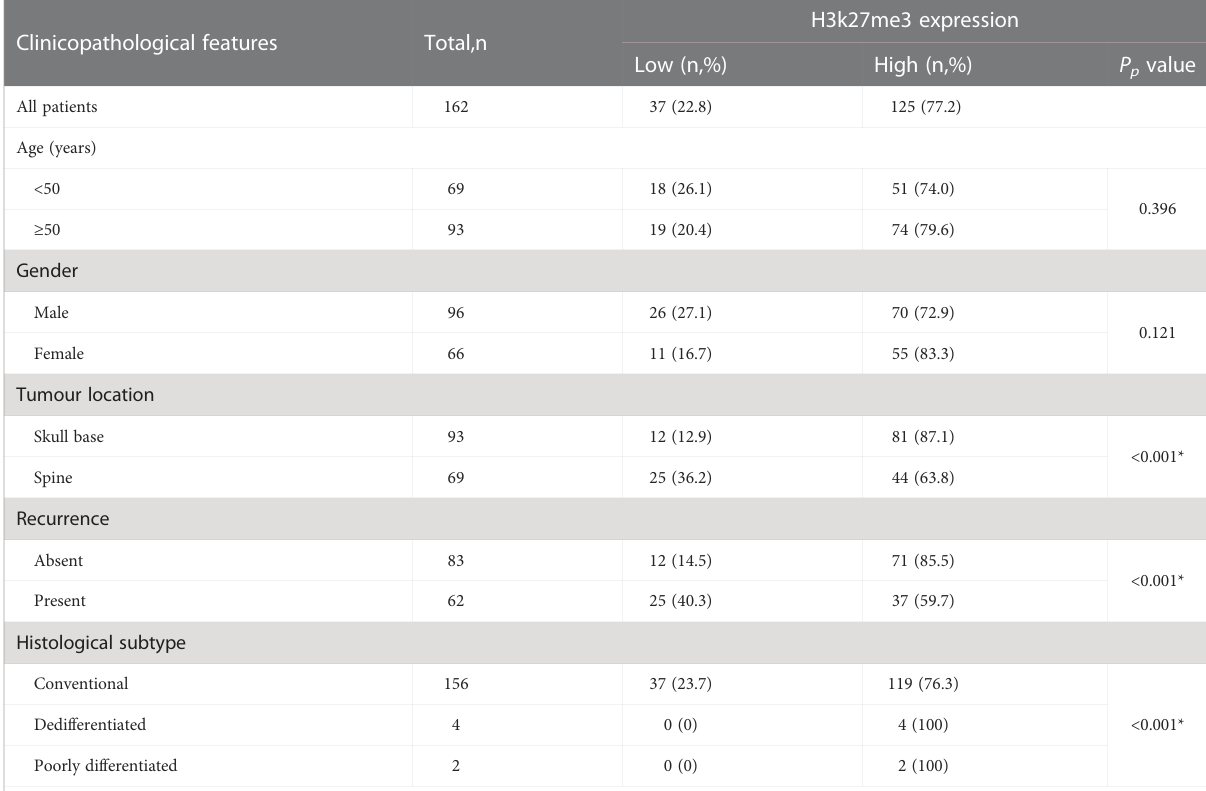
TABLE 1 Characteristics of patients with